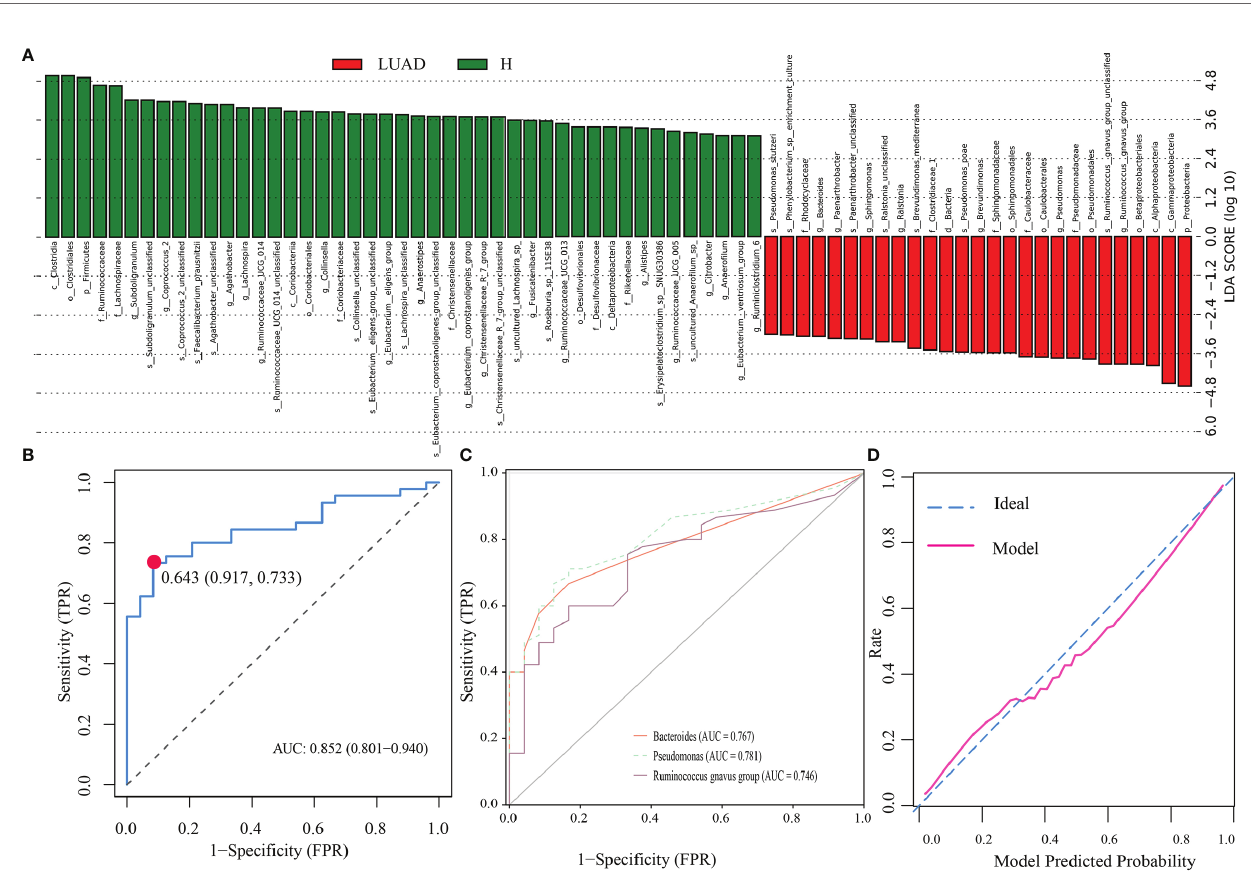
FIGURE 4 | Identi fi cation of biomarker ’ s taxa and construction of a diagnostic model. (A) The LefSe analysis identi fi ed taxa meeting thresholds: P < 0.01 and LDA > 3. (B) The ROC of the diagnostic model. (C) The ROC of three biomarker ’ s taxa. (D) The calibration plot of the diagnostic model. LsfSe, Linear discriminant analysis (LDA) effect size; ROC, The receiver operating characteristic curve; AUC, the area under the